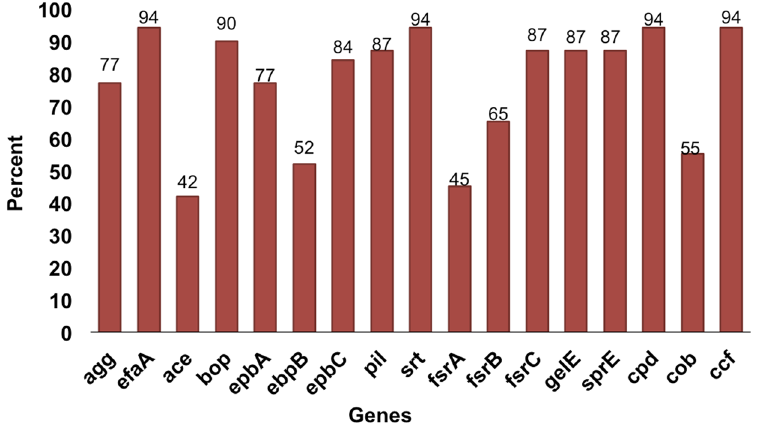
Figure 3. Results of PCR analysis of the distribution of each of the genes involved in biofilm